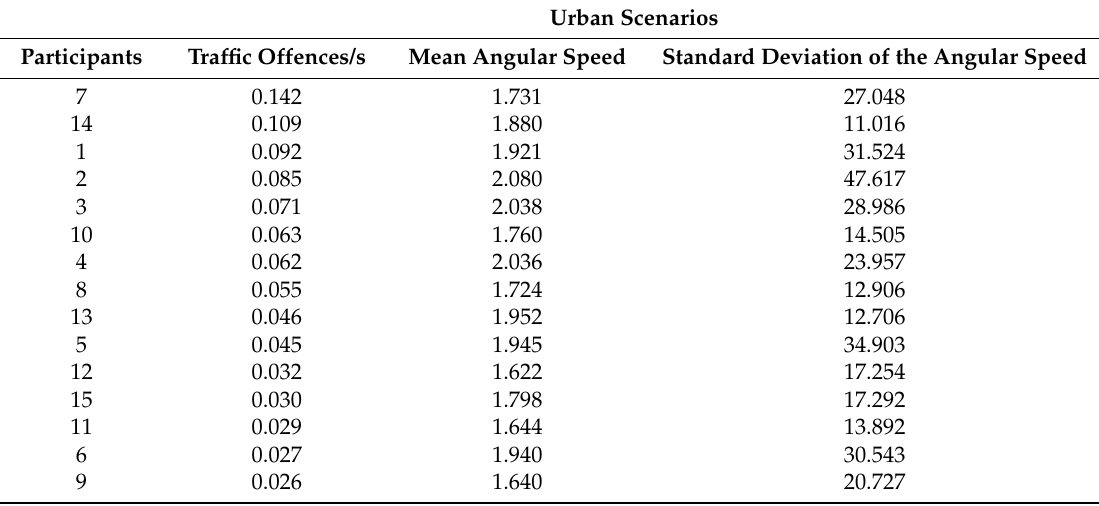
Table 1. Participants ordered as a function of the number of traffic offences per second in urban scenarios.